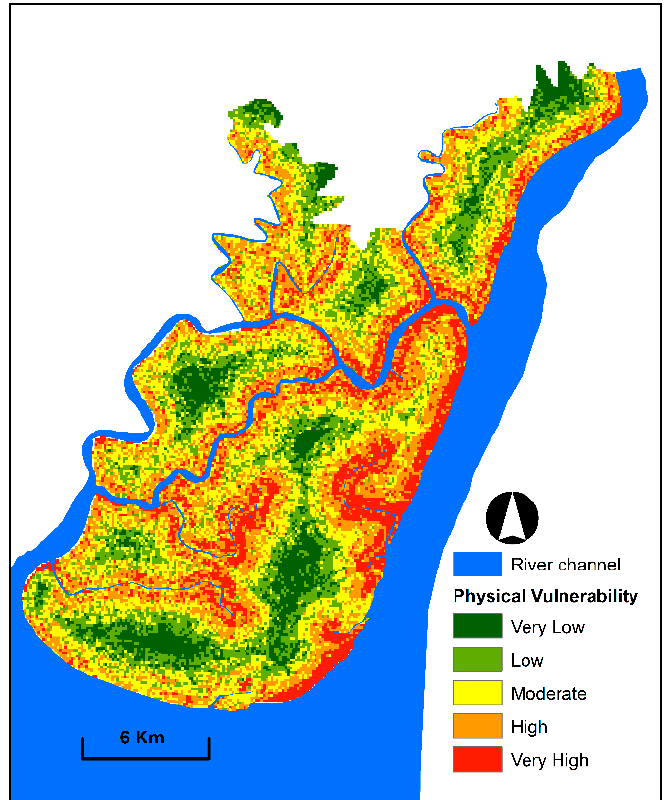
Figure 6. Physical vulnerability map exhibiting spatial patterns and degree of physical vulnerability to